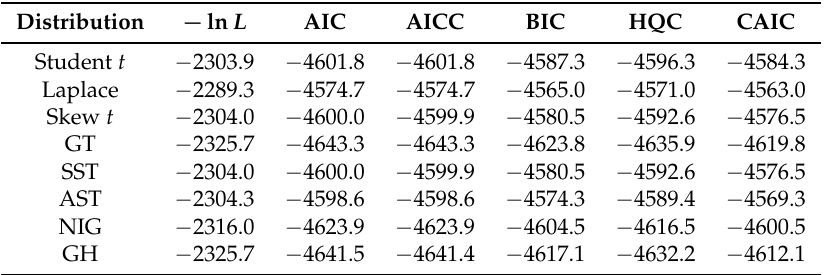
Table 4. Fitted distributions and results for daily log returns of the exchange rates of Bitcoin from